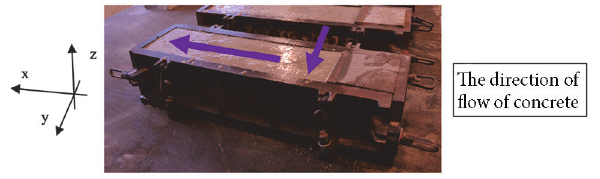
Figure 2. T Production of samples